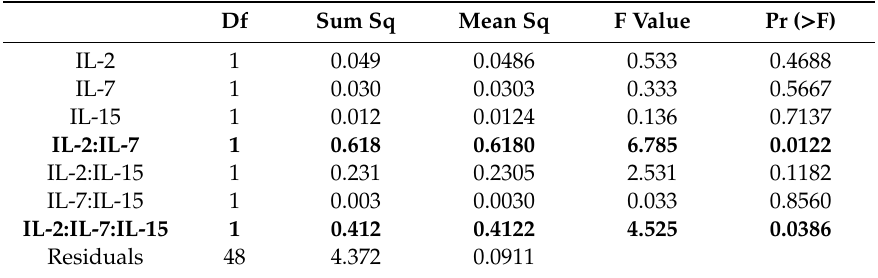
Table 3. Statistical analysis of interaction of IL-2, IL-7, and IL-15 in influencing activated CD4 + T-cell growth rates by factorial analysis of variance (ANOVA). The analysis was conducted with R Studio’s “aov” command, and normality of residuals and homogeneity of variances were verified using the Shapiro and Bartlett tests, respectively. Pr ( > F) of less than 0.05 was used to test for significance of interaction between interleukins. Significant interaction between IL-2 and IL-7 indicates that the e ff ect of IL-2 is not consistent across all levels of IL-7, and the converse, suggesting an interactive e ff ect of both present.